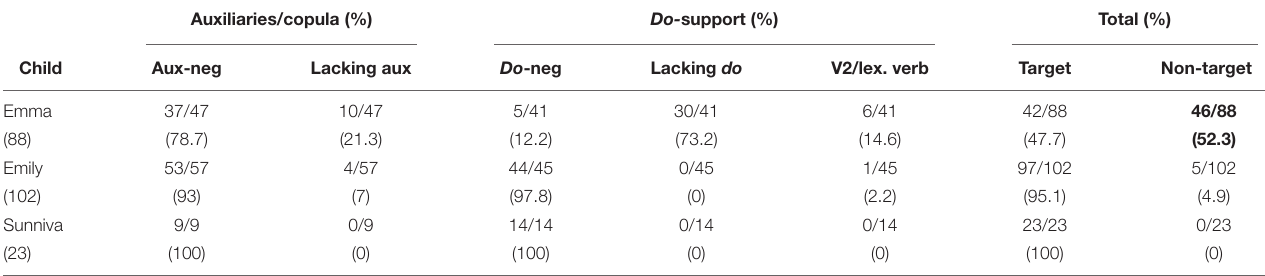
TABLE 6 | Finite verb placement in negative declaratives (requiring an auxiliary or do -support) in Emma, Emily and Sunniva’s files. Auxiliaries/copula (%)